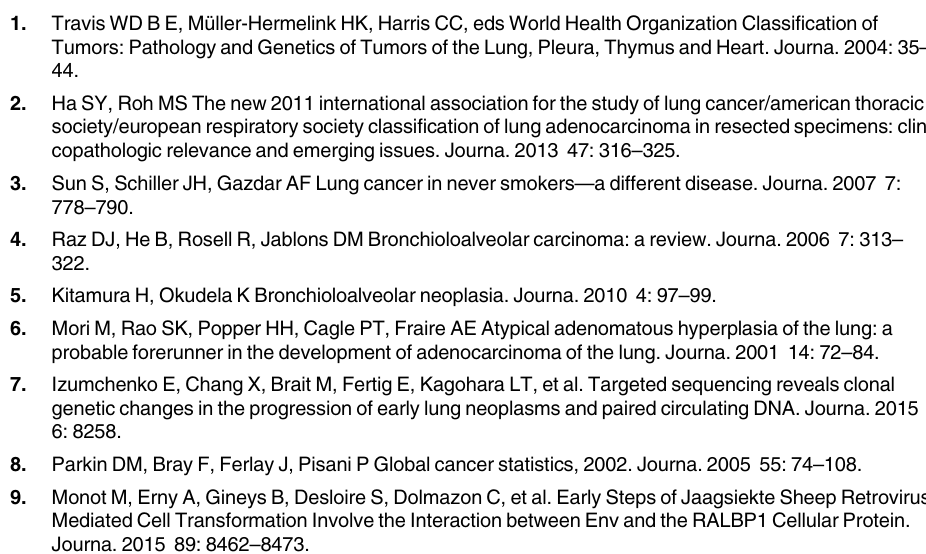
S1 Table. qRT-PCR primer sequences of EMT transcriptional factors and candidate genes. S2 Table. IPA analyzed genes related to cellular movement and migration. S3 Table. Statistics of key transcriptional factors of EMT from real-time qPCR of Tg-3m and Tg-6m cell lines. S4 Table. Statistics of candidate genes associated with EMT from real-time qPCR of Tg- 3m and Tg-6m cell